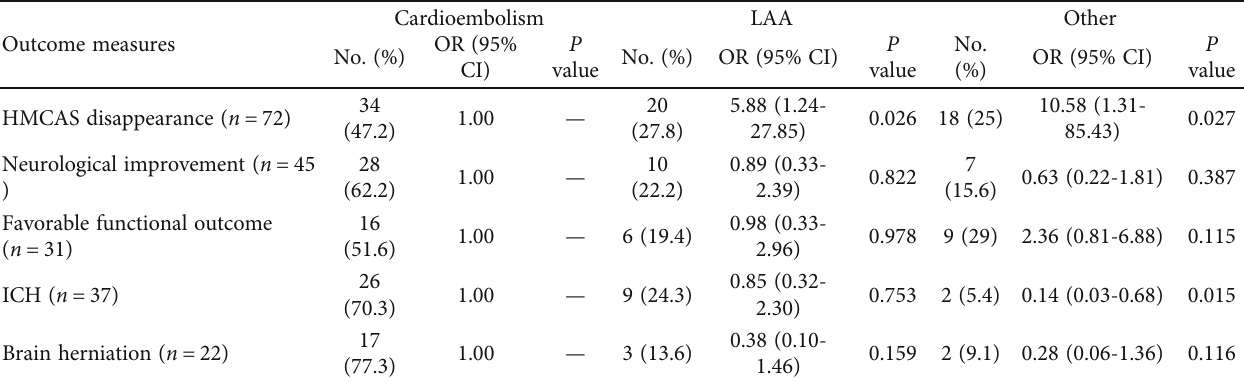
Table 4: Adjusted analysis: prognostic e ff ect of stroke subtype on outcome